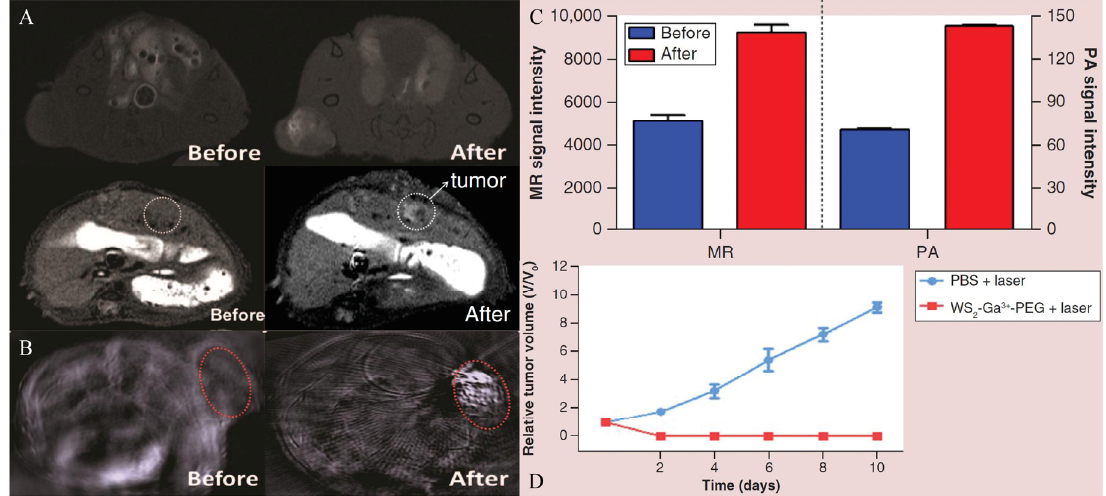
Figure 6. WS 2 -Ga 3+ -PEG-peptide nanoprobe served as a bimodal imaging and photothermal agent. Reproduced with permission Ref. [47]. Copyright 2018 Future Medicine LTD. ( A ) The MR imaging in subcutaneous and orthotopic HCC models. ( B ) The photoacoustic imaging in subcutaneous HCC models. ( C ) The quantified signal intensities of MR and photoacoustic imaging. ( D ) Effect of photothermal therapy in subcutaneous HCC